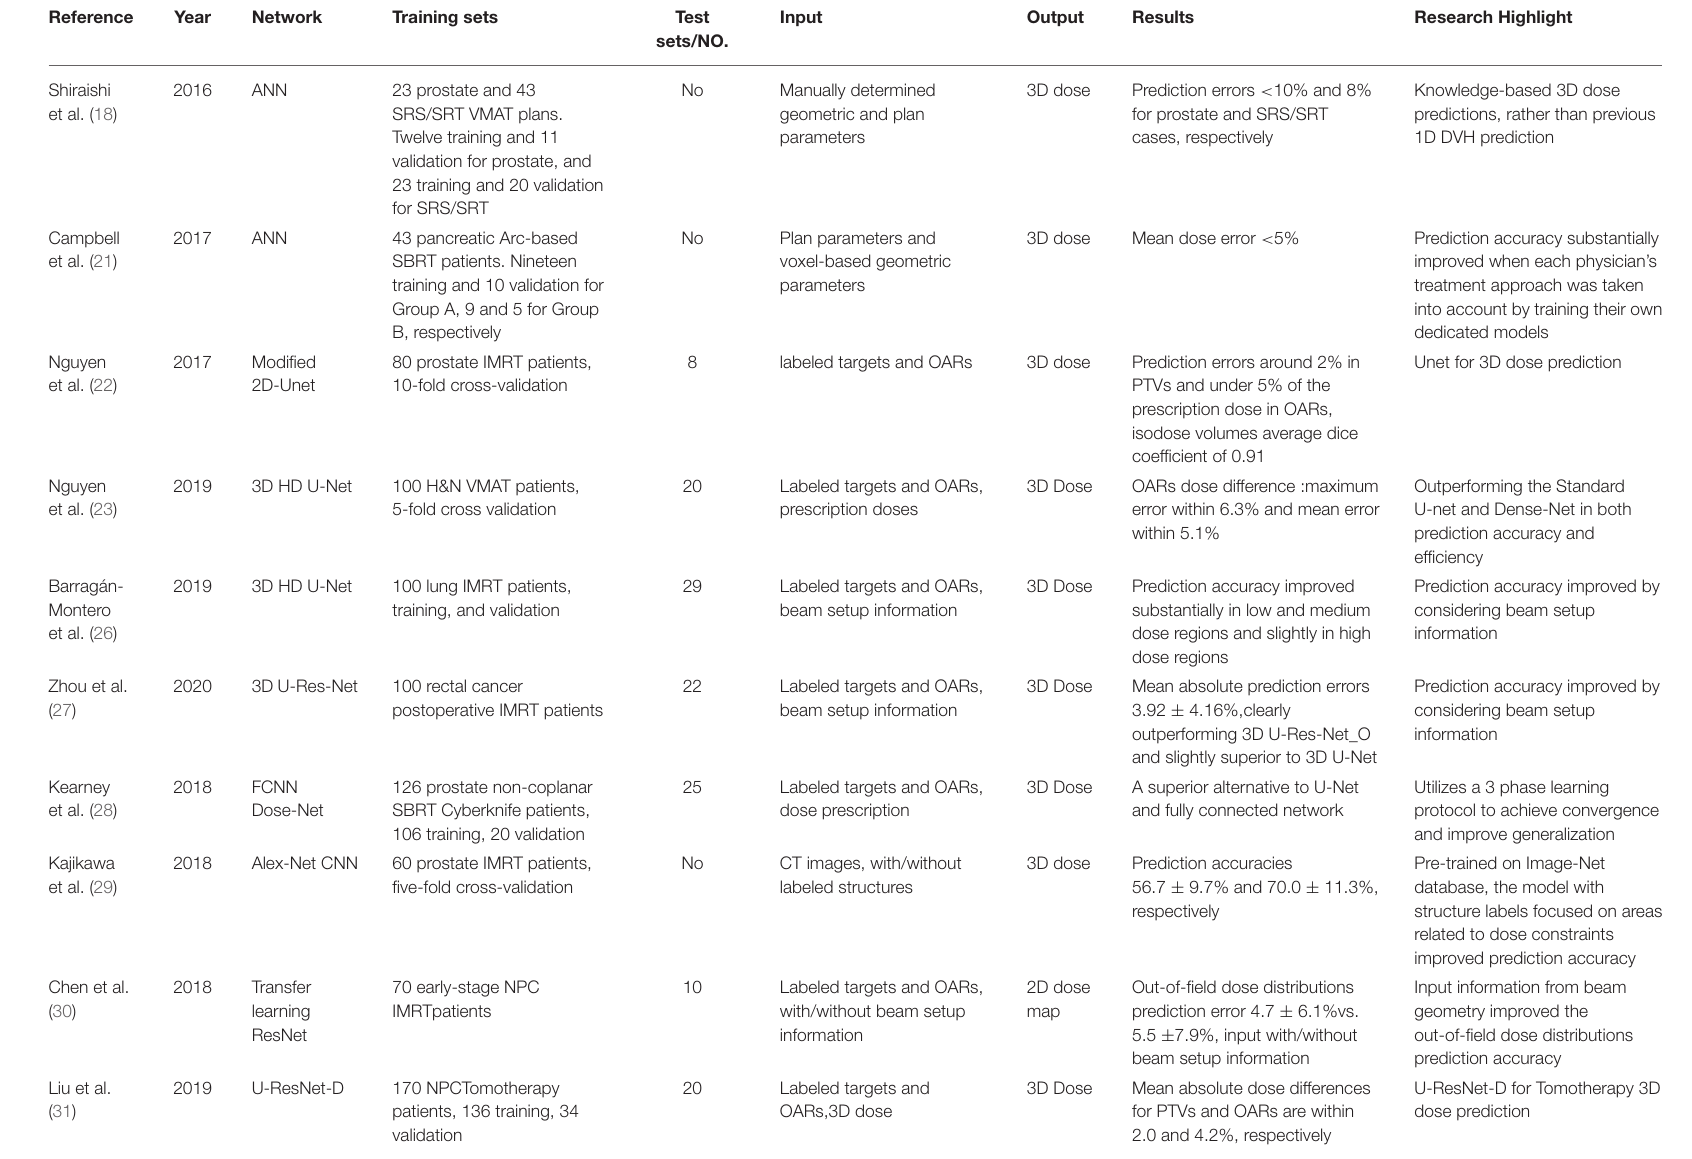
TABLE 1 | Selected studies on deep learning-based automated radiotherapy planning. Reference